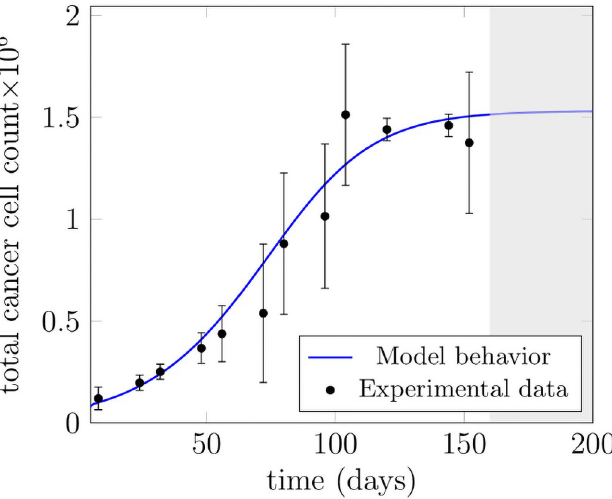
Fig 10. Model fitting to the experimental data. The model has been validated with the data set derived by TUBO Cancer cell line [57]. The experimental data are represented by black error bars representing mean ± standard deviation. The blue line is the model fit to the experimental measurements. Our proposed model predicts an establishment of the steady-state in grey shaded area where no measurements of cell count were available.